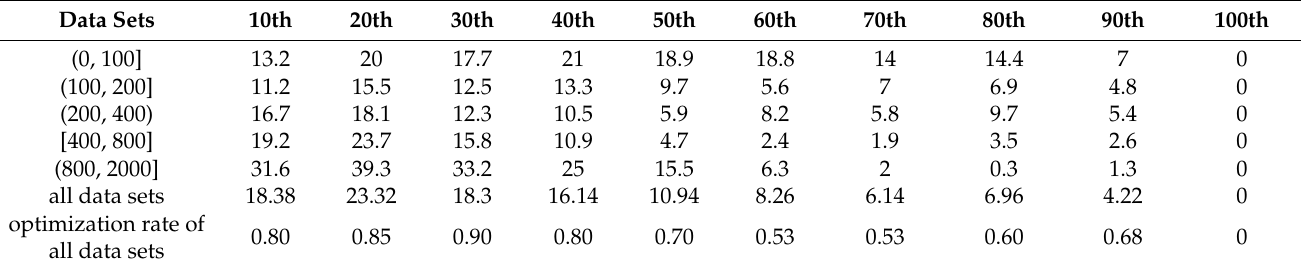
Table 5. The average saving generations of SEACO algorithm than ACO algorithm on all data sets.